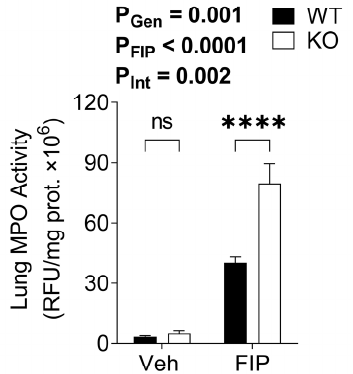
Figure 5. Lung neutrophil infiltration, as assessed by myeloperoxidase activity (MPO,) in wild-type (WT) and OSMR type II receptor knockout (KO) mice subjected to fecal slurry (FS)-induced peritonitis (FIP) or treated with vehicle (Veh). The p values reflect the outcomes of 2-way analysis of variance; Sidak post-hoc tests outcomes are shown as **** p < 0.0001, ns not significant. Each bar represents n = 3–12 mice.